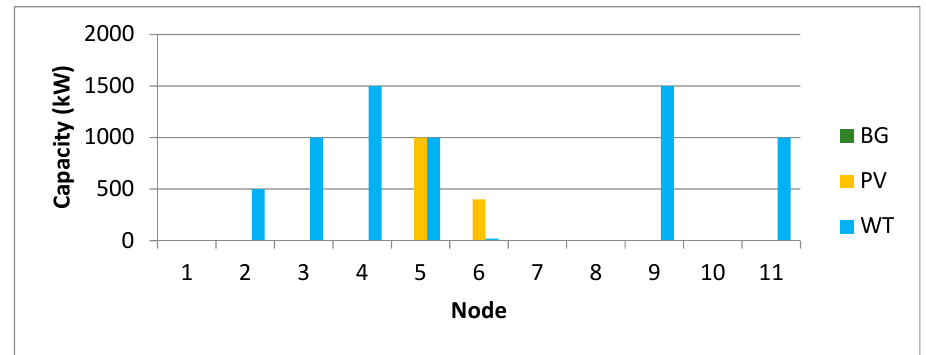
Figure A5. Capacity structure for 40% share of energy from RES in total demand with sizing and allocation of RES and ES.